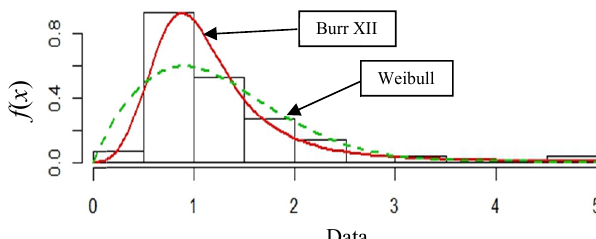
Fig. 3. The fitted PDF and relative histogram for the degree of splashing.